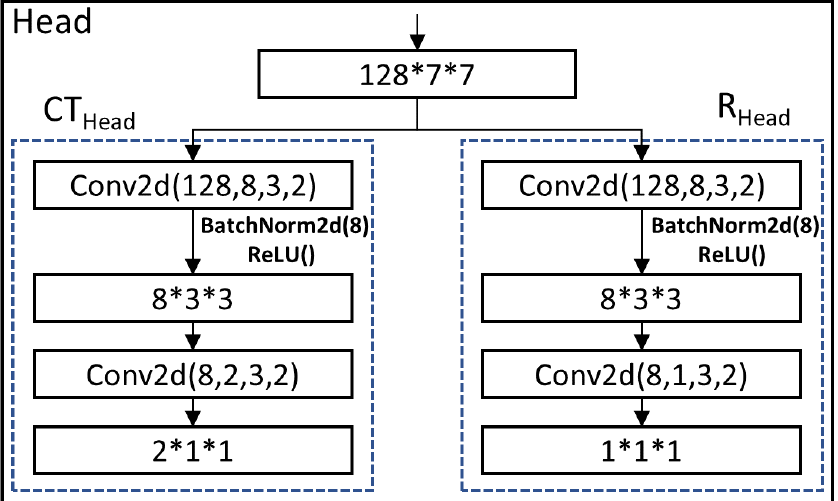
Figure 8. The structure of the prediction